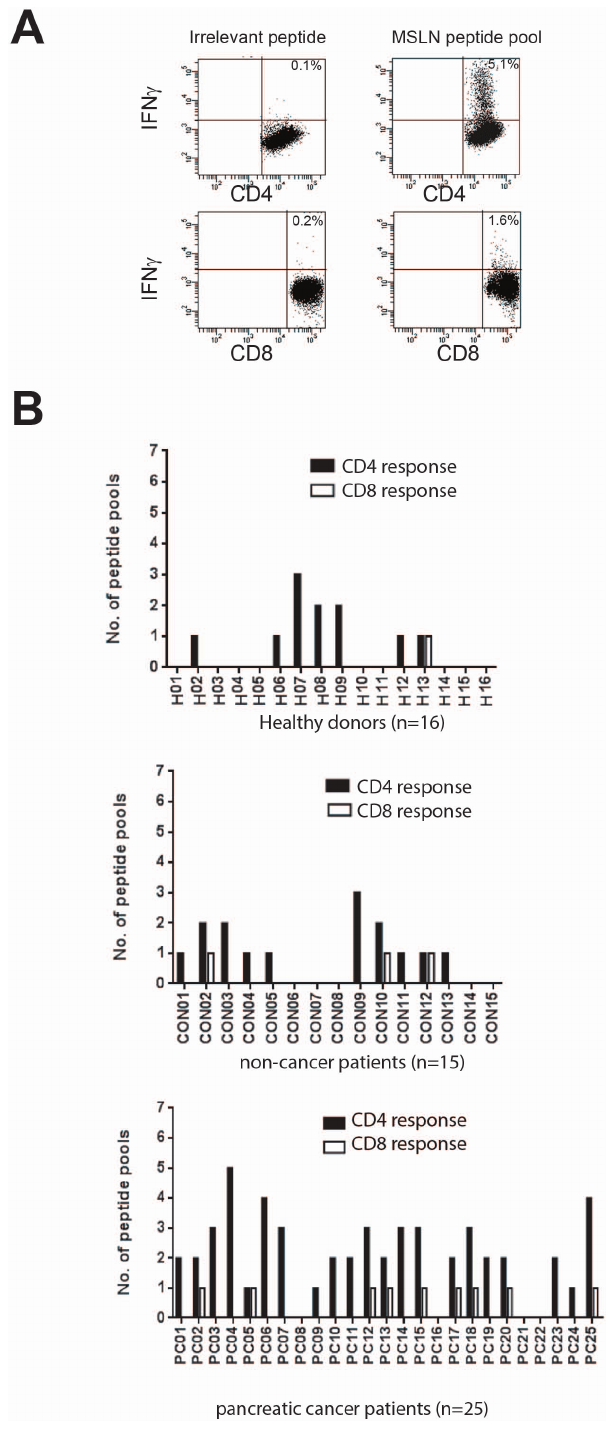
Figure 3. Mesothelin (MSLN)-specific IFN- c producing CD4 + and CD8 + T cell response. Representative FACs plots of IFN- c production by CD4 + and CD8 + T cells from short term T cell lines following re- stimulation with MSLN-derived peptides or an irrelevant peptide are shown. The production of MSLN-specific IFN c by CD4 + and CD8 + T cells was assessed using intracellular cytokine staining assay. Numbers in the top right quadrants are the percentage of cytokine-producing cells within viable CD4 + or CD8 + T cells (A). The number of peptide pools (7 peptide pools in total) that stimulated IFN- c production by CD4 + or CD8 + T cells isolated from 16 healthy donors, 15 patients with